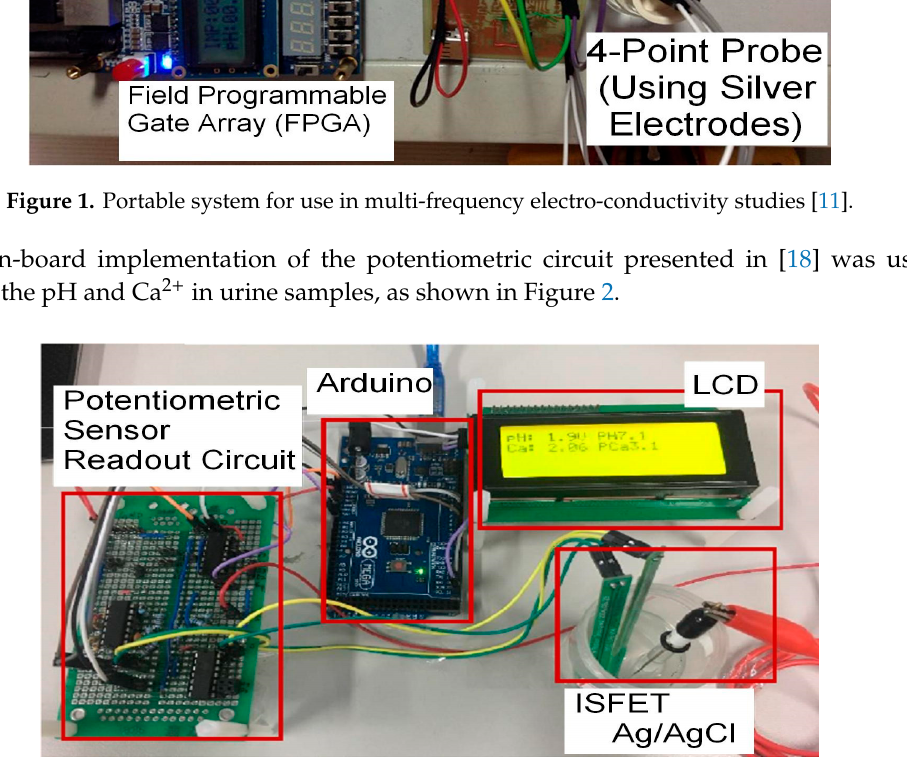
Figure 2. The on-board prototype of the potentiometric readout system [18].